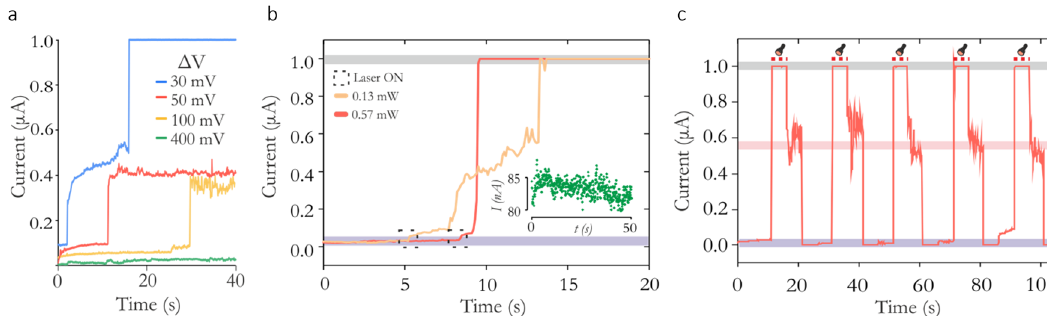
Fig. 2 Switching dynamics in volatile Pt/GeSe 3 /Ag devices. A Stochastic switching processes under dark conditions. Δ V is the difference between the applied constant bias and the device ’ s intrinsic switching voltage. B Light-induced switching under a sub-threshold illumination intensity, and at high optical intensity illumination for bias polarity that produces positive short-circuit current. Inset is the device current under dark conditions. C Switching behavior of the device to pulsed illumination. For threshold illumination, the device spontaneously switches to LRS.